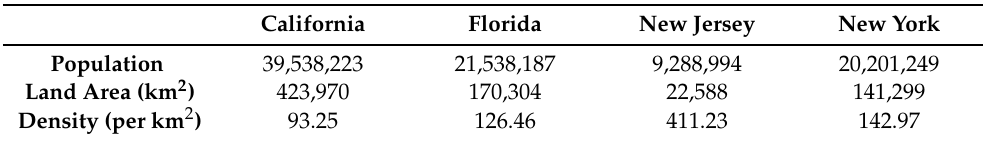
Table 1. The number of the population and land area of 4 states collected by the U.S. Census